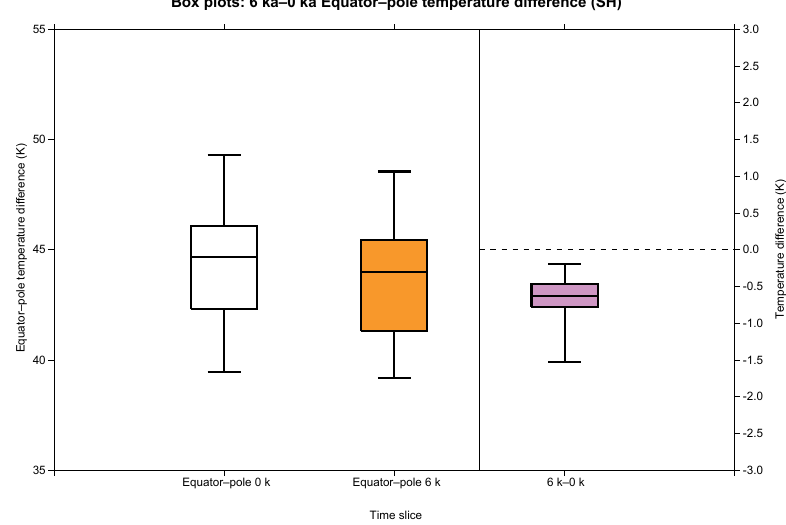
Figure 10. Box-and-whisker plots of the individual model mean difference in surface temperature between 30 ◦ N and 30 ◦ S and 60–90 ◦ S in the 0ka simulations (white boxes, left axis, K) and the 6ka simulations (amber boxes, left axis, K). The pink box (associated with the right axis, K) is the individual model difference in the Equator-to-pole temperature gradient for 6ka relative to